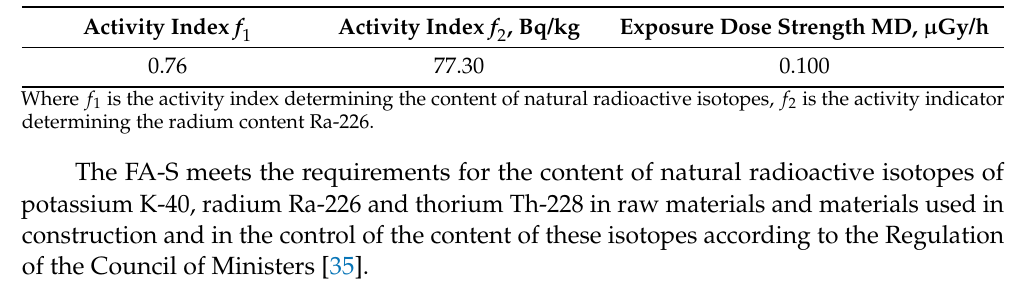
Table 4. Artificial lightweight aggregate fractions of 0–2, 1–4 and 4–8 mm [36].